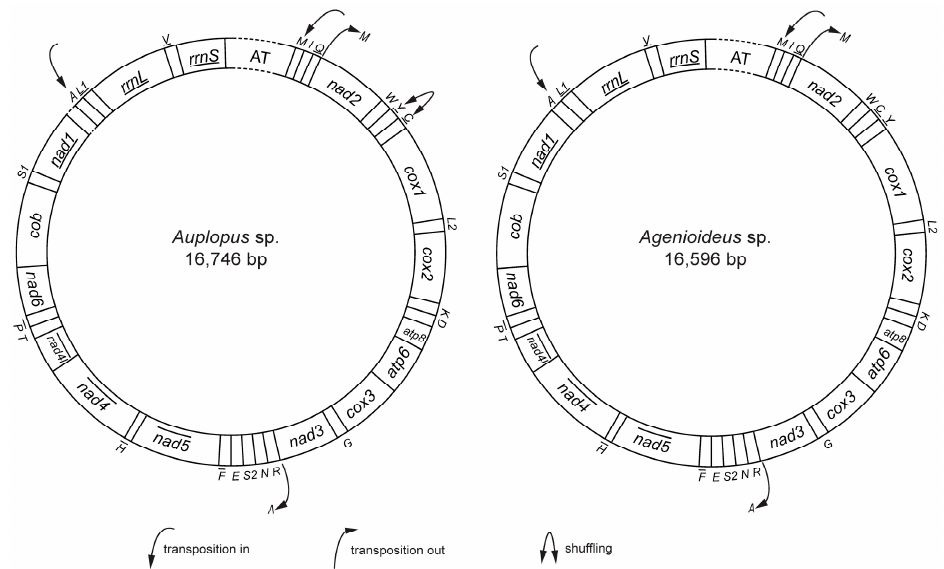
Figure 1. Map and rearrangement of the mitochondrial genomes in Agenioideus and Auplopus . Genes with underscores are encoded on the minority strand. Dashed lines indicate the unsequenced region of the genome. cox1 , cox2 , and cox3 : cytochrome oxidase subunits; cob : cytochrome b; nad1 - nad6 : NADH dehydrogenase components; rrnL and rrnS : ribosomal RNAs. One-letter symbol refers to the transfer RNA gene according to the IPUC-IUB single-letter amino acid codes. L1, L2, S1 and S2: tRNA Leu(CUN) , tRNA Leu(UUR) , tRNA Ser(AGN) , and tRNA Ser(UCN) .